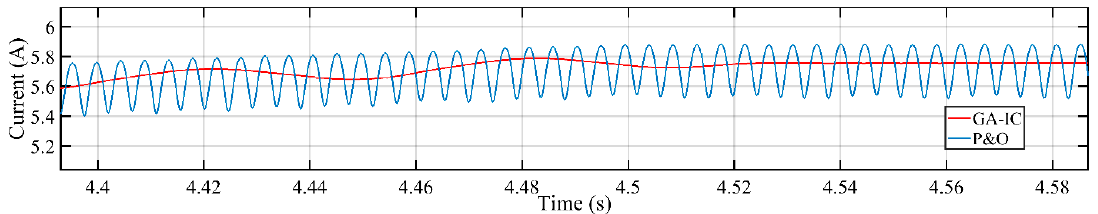
16 of 24 Figure 24. Case 2 power comparison of modified GA-IC vs. P&O. Figure 25. Case 2 power, detailed comparison of modified GA-IC vs. P&O. Figure 26. Case 2 voltage comparison of modified GA-IC vs. P&O. Figure 27. Case 2 voltage, detailed comparison of modified GA-IC vs. P&O.